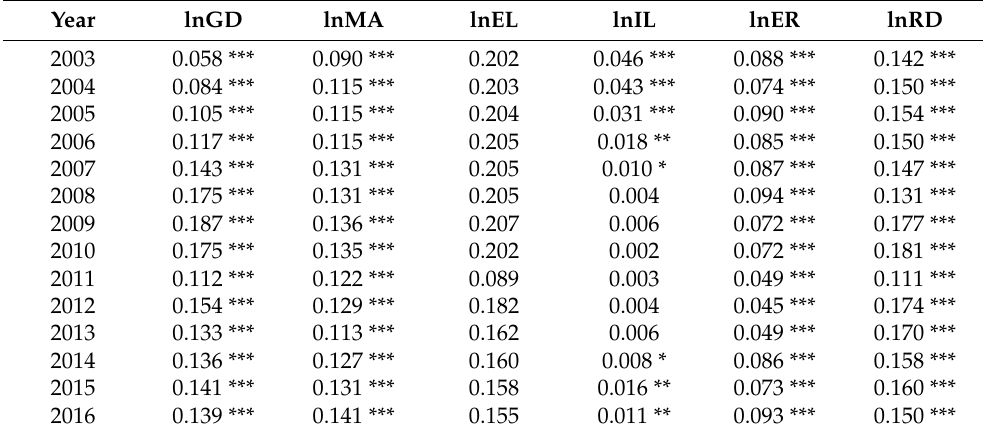
Table A3. Global Moran’s I Statistics and Their